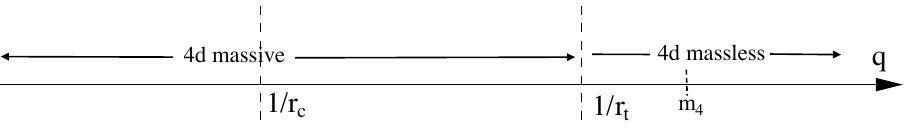
Figure 9 . Graphical representation of the di(cid:11)erent regimes (depending on momentum) of the brane-to-brane propagator, in the case r t < r c . In this example, we have chosen to set the massive gravity transition scale m 4 > 1 =r t , thus the transition across q ’ 1 =r t goes directly to a four- dimensional massive propagator.